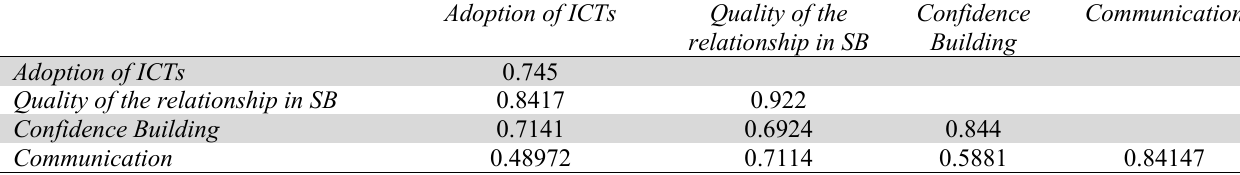
Correlation matrix